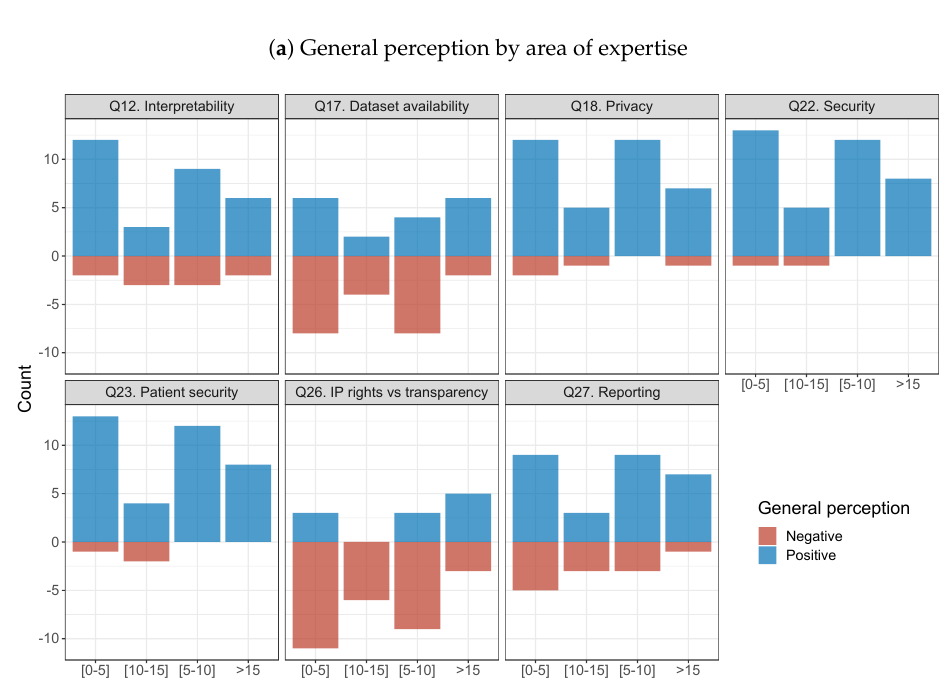
Figure 3. General perception of the survey respondents stratified by area of expertise and by years of